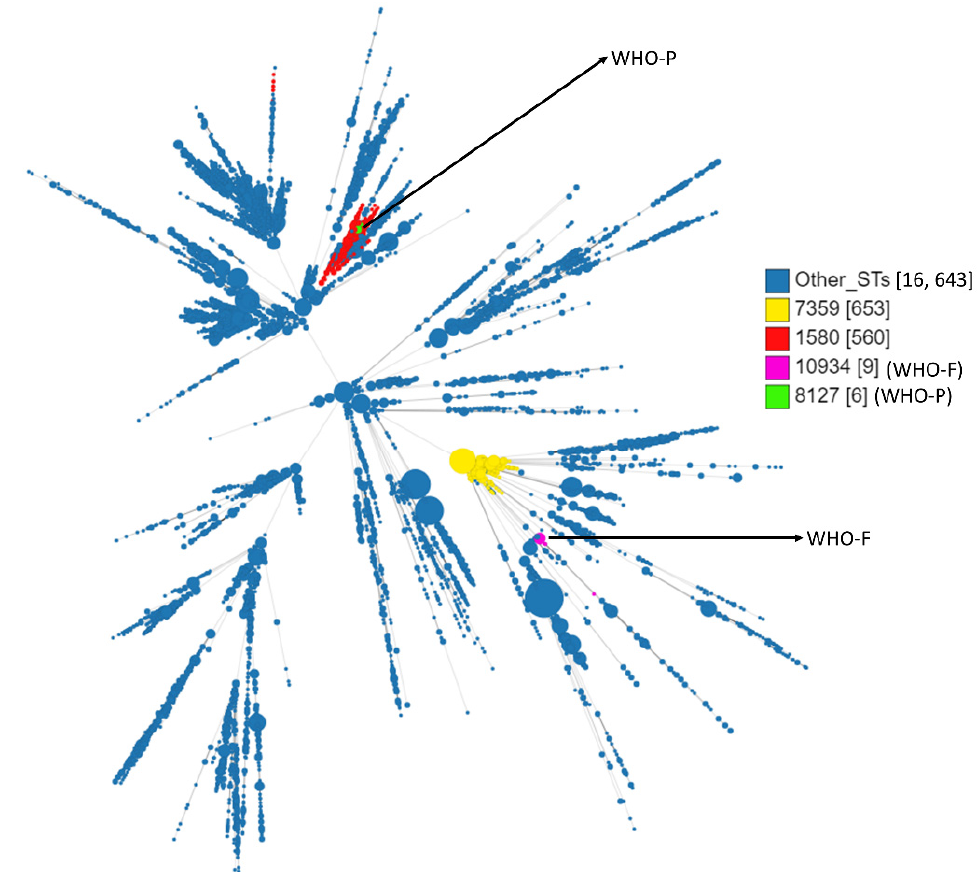
Figure 1. Minimum spanning tree comparing core-genome allelic profiles with MLST resulting in isolates with similar allelic profiles forming clusters. Isolates are displayed as circles. The size of each circle indicates the number of isolates of this particular type. Numbers in brackets refer to the number of isolates. WHO-F (ST10934) is denoted in magenta colour and WHO-P (ST8127) in green